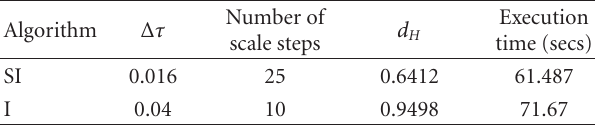
Table 2: Comparisons between two algorithms: E d = O (10 − 2 ).